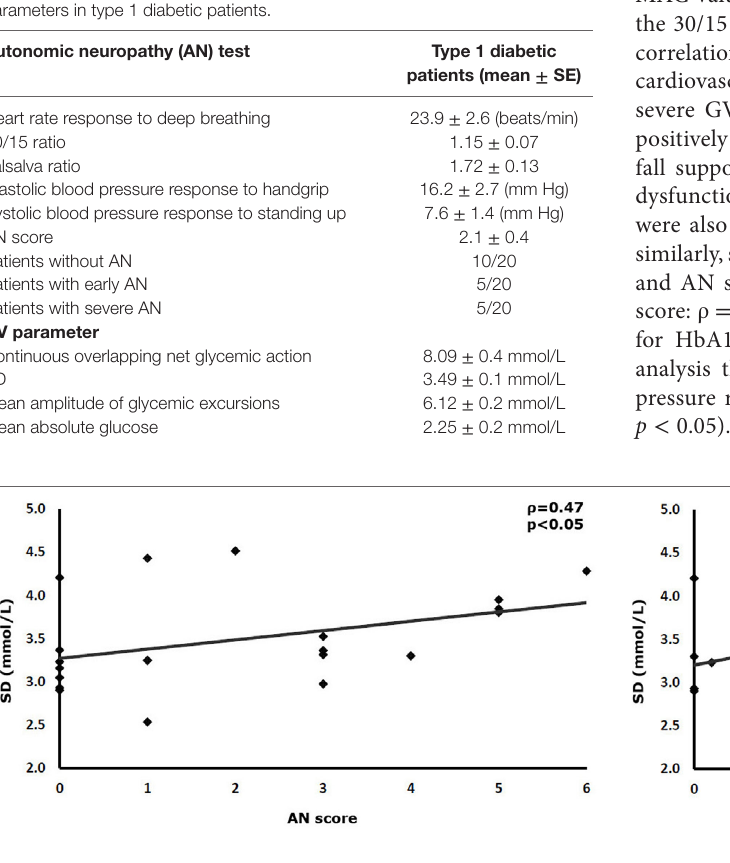
FigUre 1 | Correlations between SD of continuously measured interstitial glucose levels and cardiovascular reflex